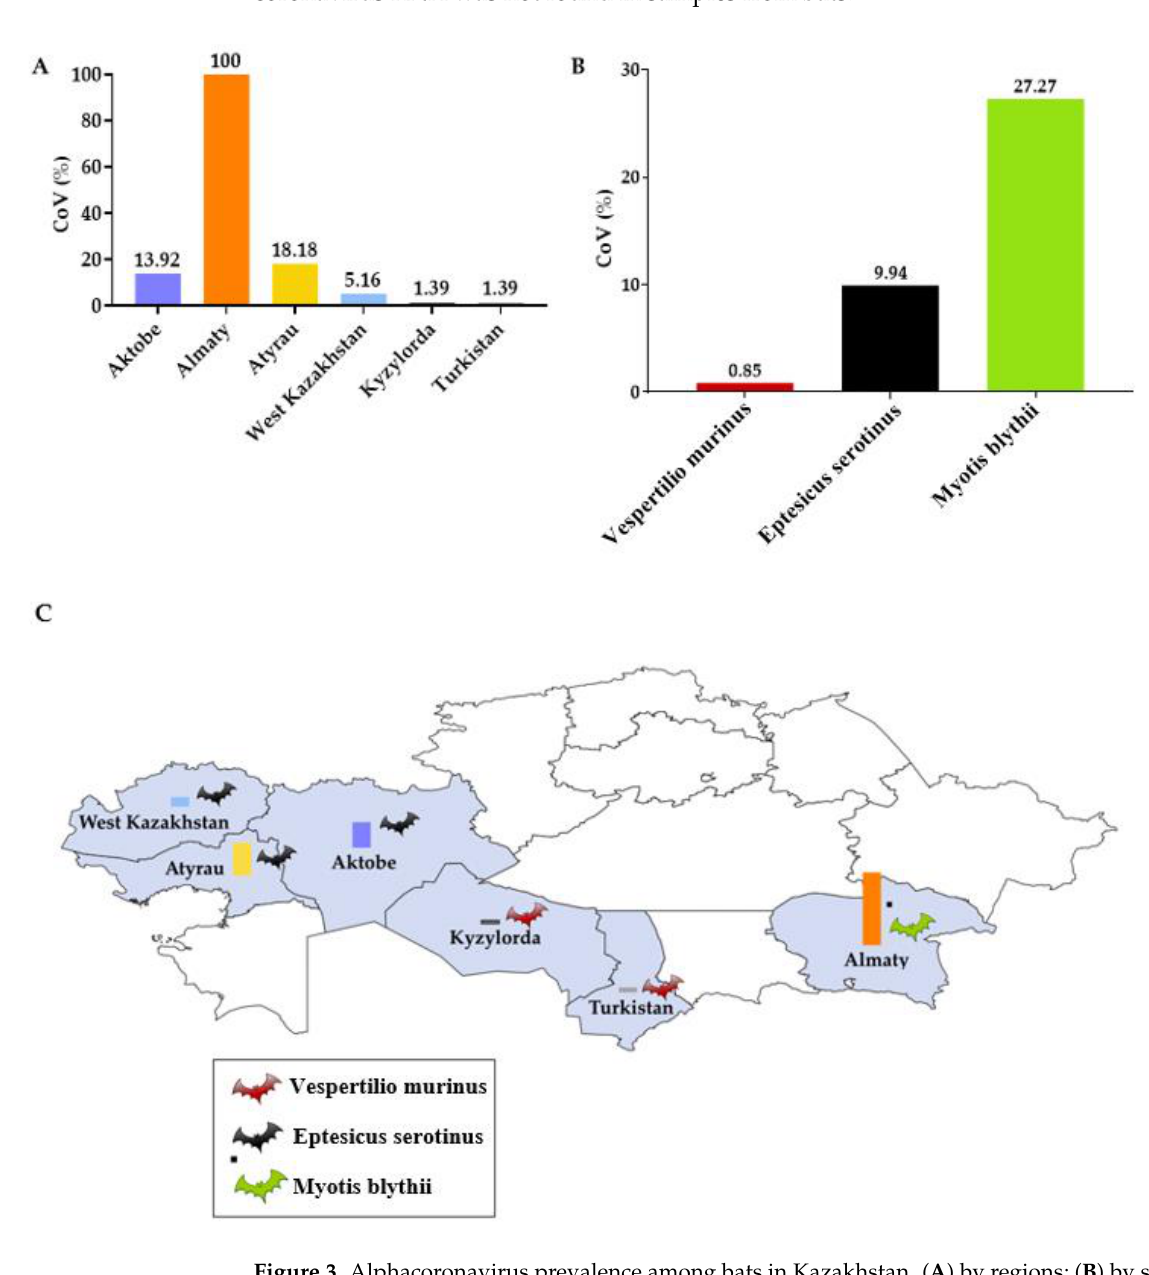
Figure 3. Alphacoronavirus prevalence among bats in Kazakhstan. ( A ) by regions; ( B ) by species of bats; ( C ) distribution map.